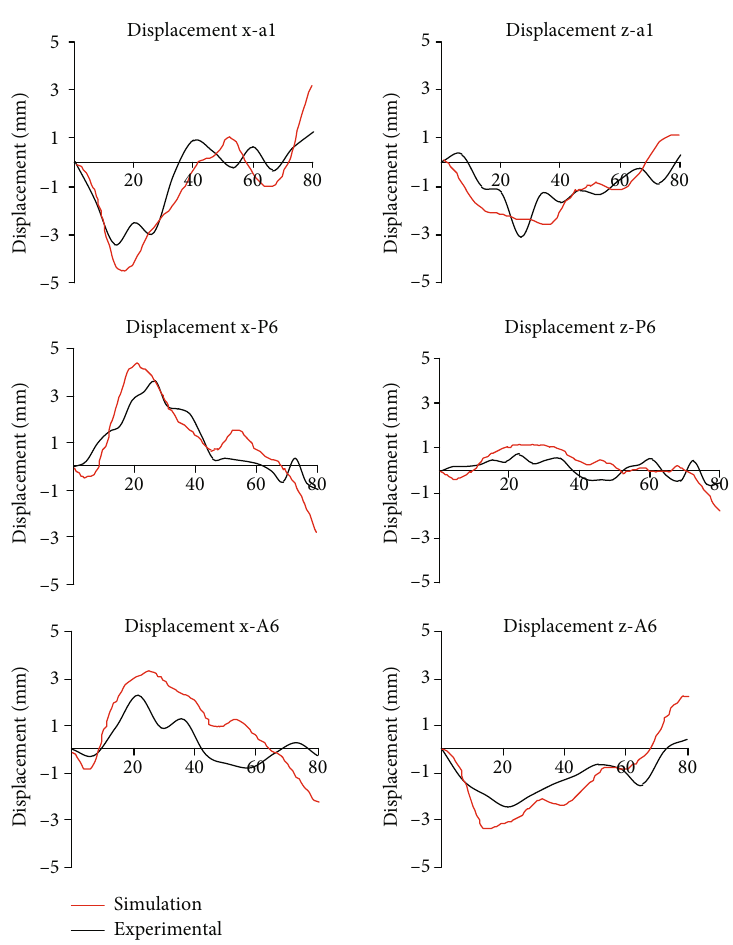
Figure 5: Comparison of relative displacement curves of brain in C383-T3 experiment and